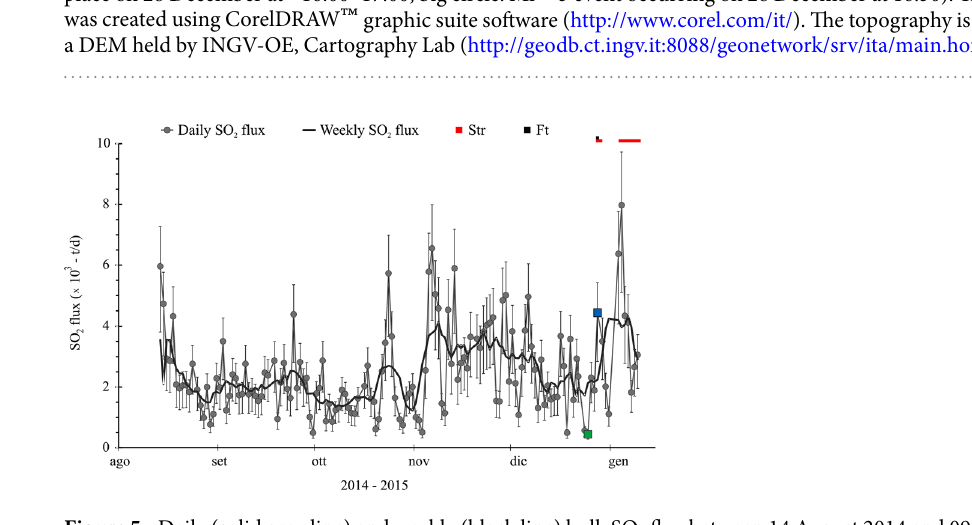
considerations can be made by looking at the borehole strainmeter data 32 , which revealed variations of the strain field with opposite polarity and diverse magnitude two hours before (13:50) and at the onset of the eruption (16:15), respectively. We interpreted these variations as: 1) an earlier positive strain (contraction), associated with